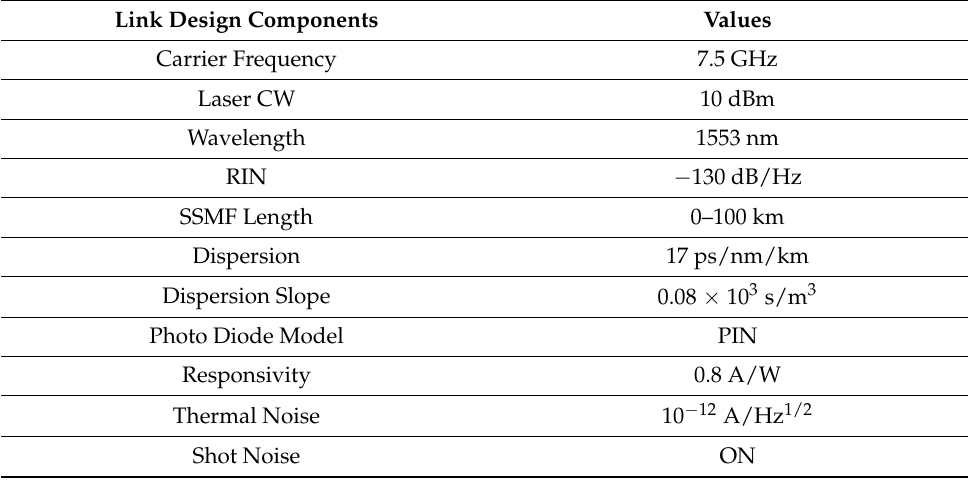
Table 2. Simulation parameters.